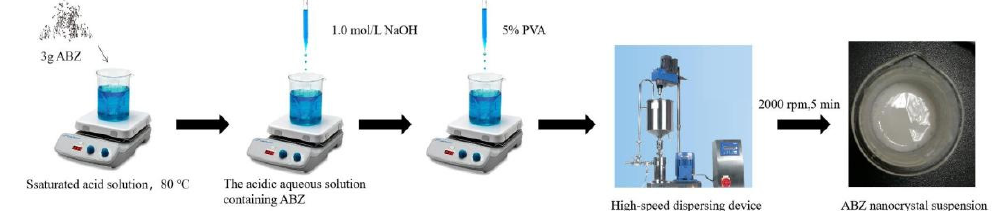
Figure 2. The schematic representation of ABZ nanocrystals preparation.